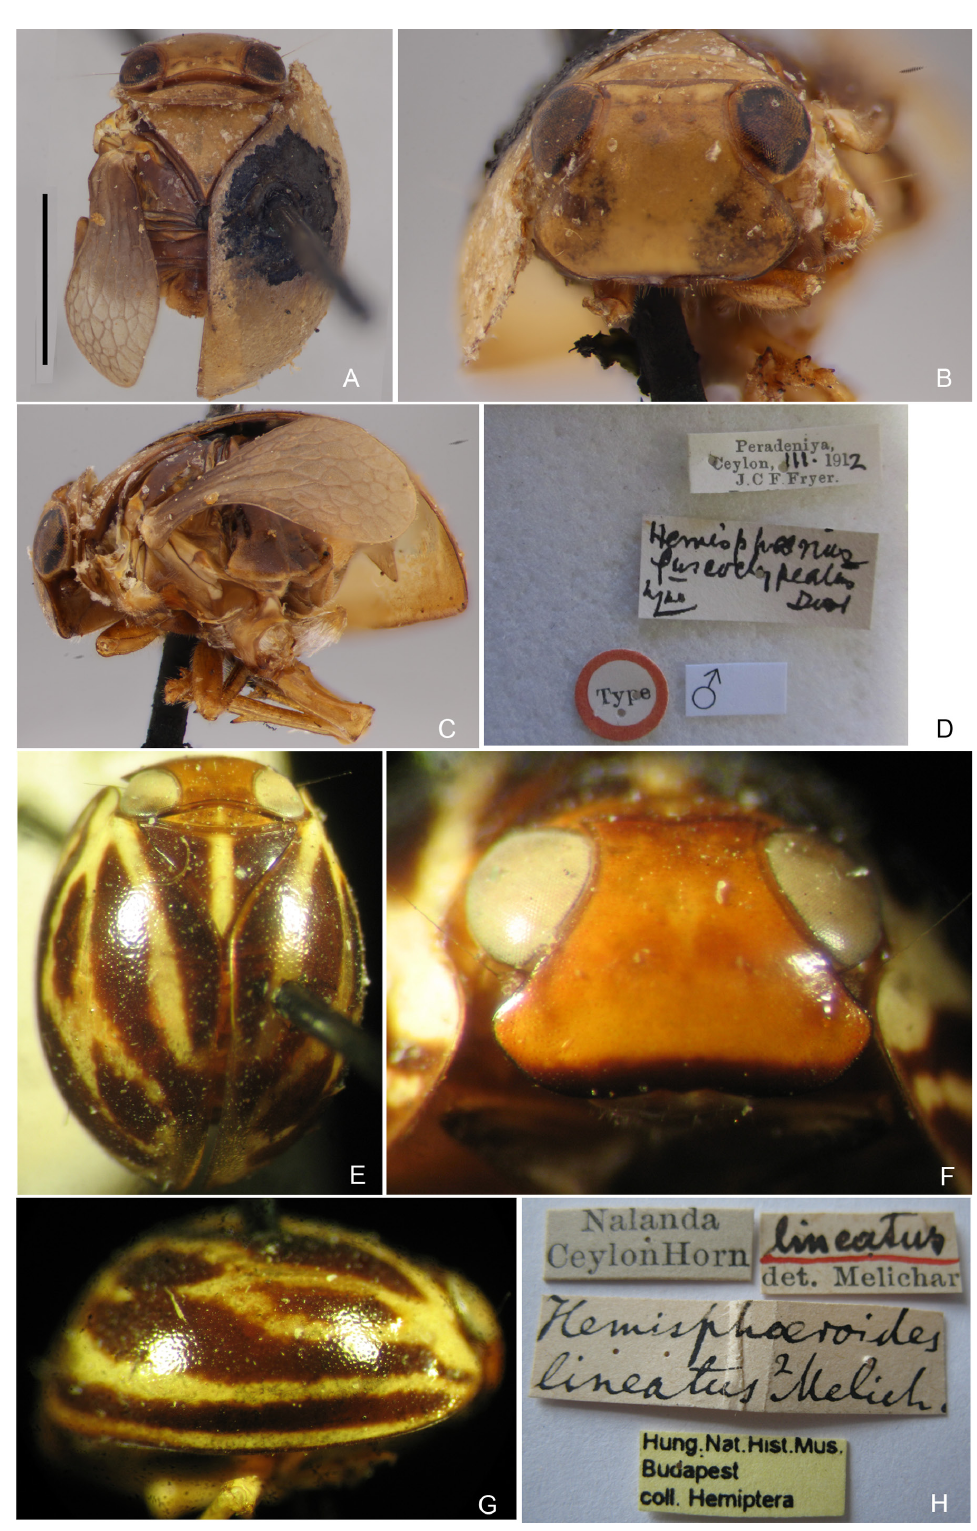
Fig. 11. Hemisphaeroides spp. A–D . Hemisphaeroides fuscoclypeatus Distant, 1916, holotype. A . Habitus, dorsal view. B . Metope and clypeus, facial view. C . Habitus, lateral view. D . Labels. — E–H . Hemisphaeroides lineatus Melichar, 1903, syntype. E . Habitus, dorsal view. F . Metope and clypeus, facial view. G . Habitus, lateral view. H . Labels. Scale bar =